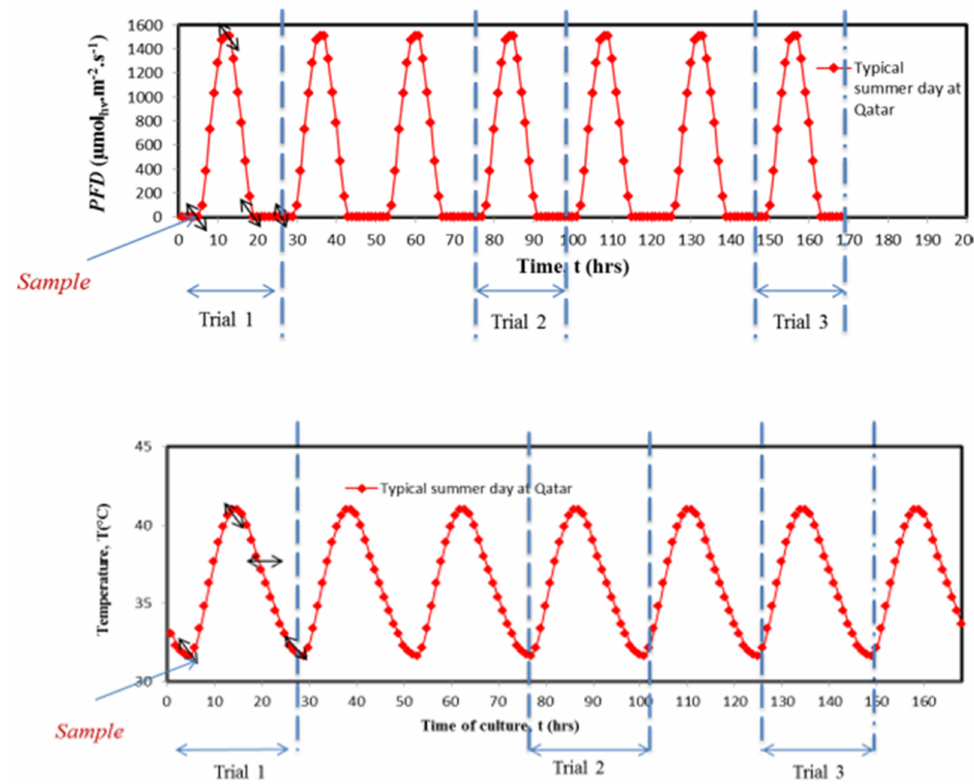
Figure 3. Experimental design of the cultivation of the N . sp QU130 under light and temperature fluctuation regimes investigated over 24 h through taking four samples upon 3 different